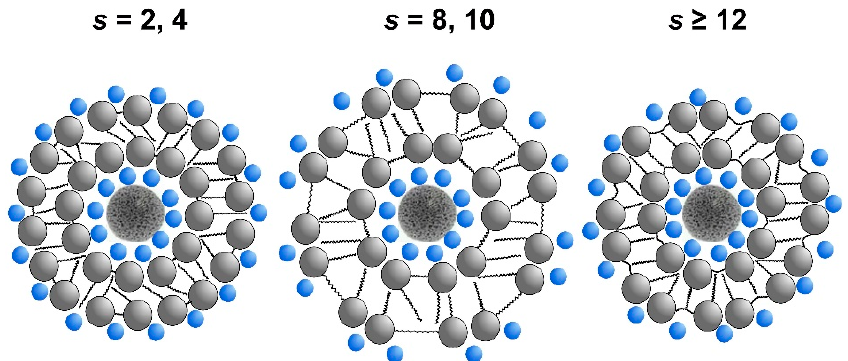
Figure 11. Interaction model between gemini molecules 12- s -12 with variable spacer length s and a silver nanoparticle. Bromide counterions are represented by smaller blue